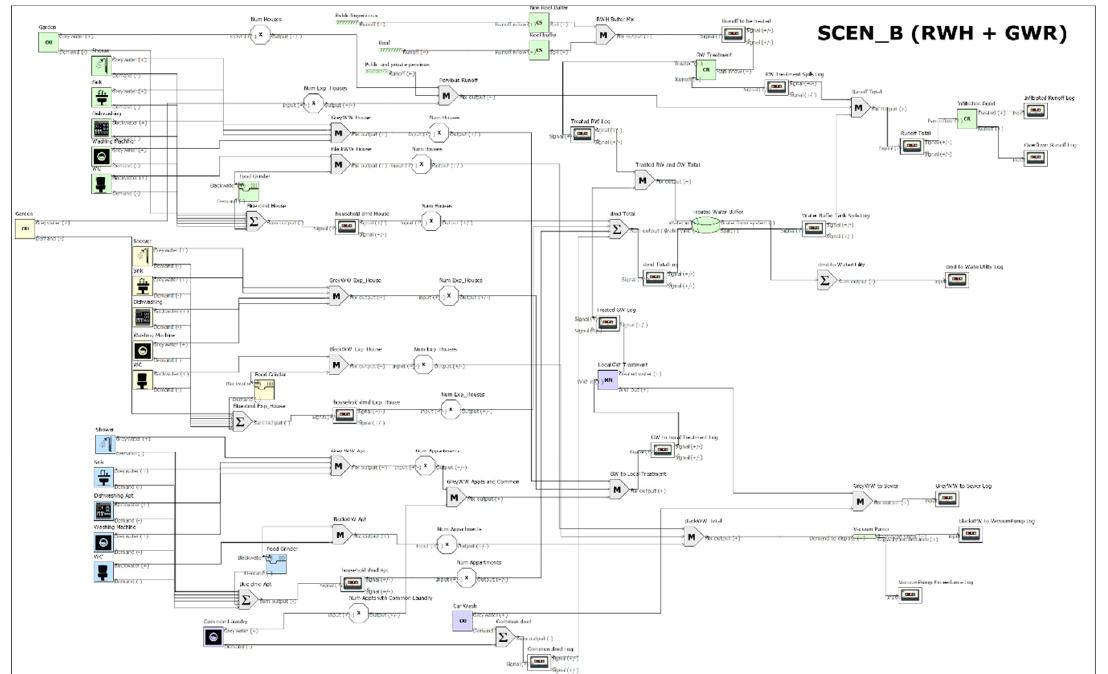
Figure 5. UWOT topologies for the two design options SCEN_A and SCEN_B.